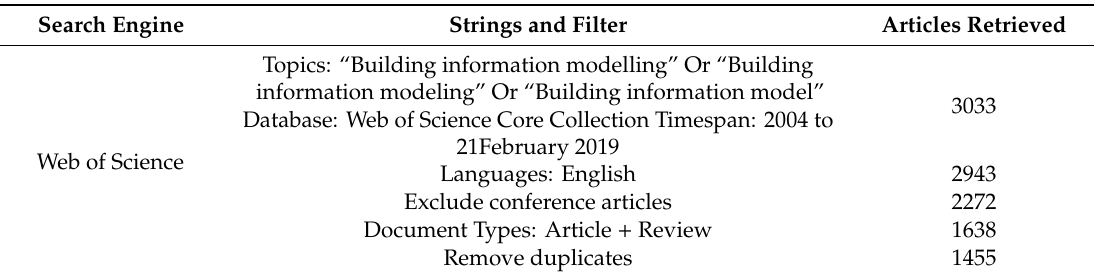
Table 1. Articles retrieved at different stages.